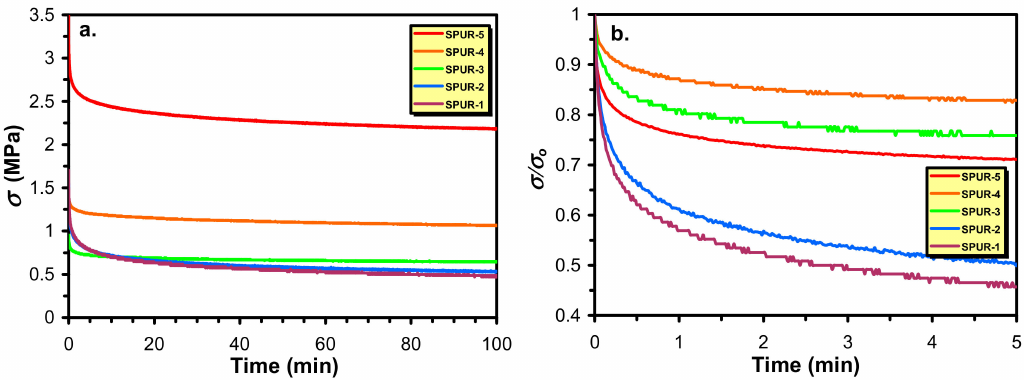
Figure 8. Stress ( σ ) ( a ) and relative stress ( σ / σ o ) ( b ) relaxation curves for the SPUR samples. The